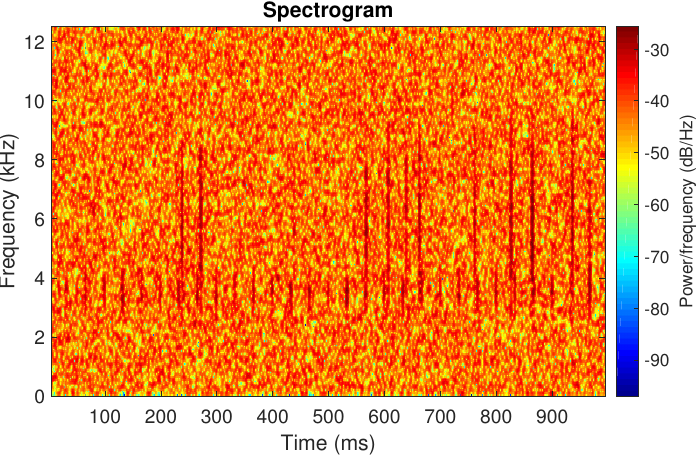
Figure 12. Spectrogram of the simulated signal s 2